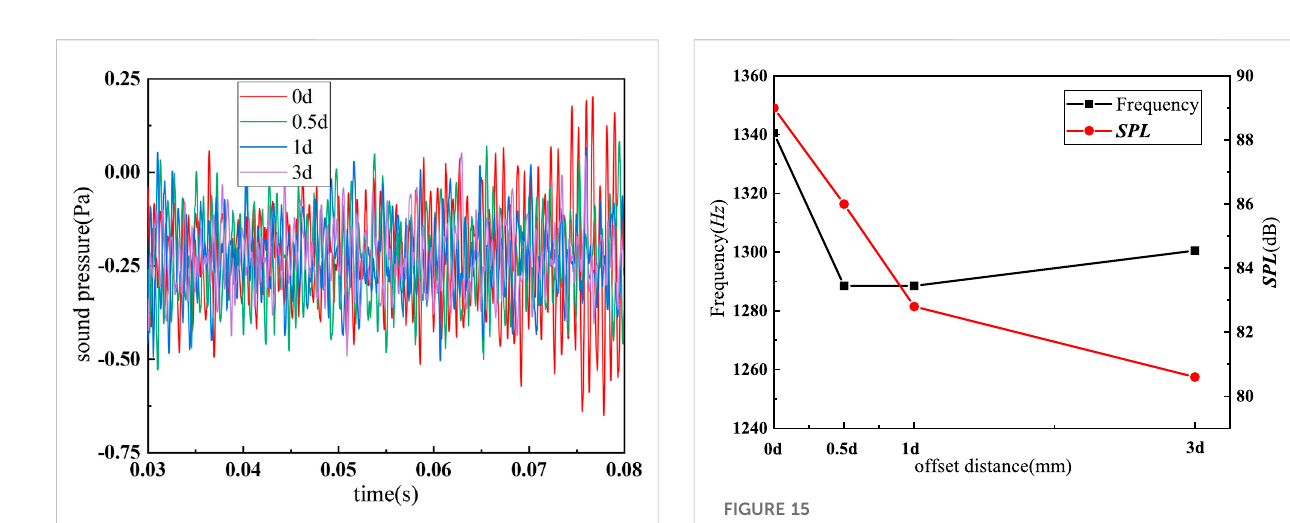
FIGURE 15 The effect of offset on peak sound pressure